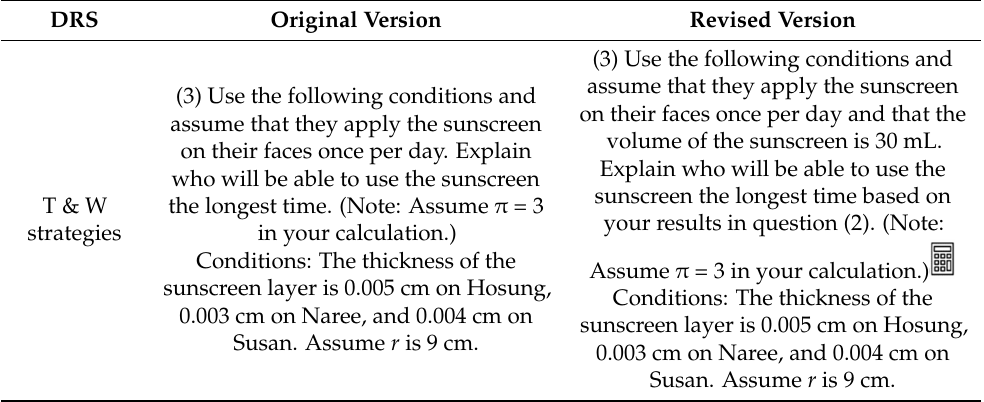
Table 11. T and W